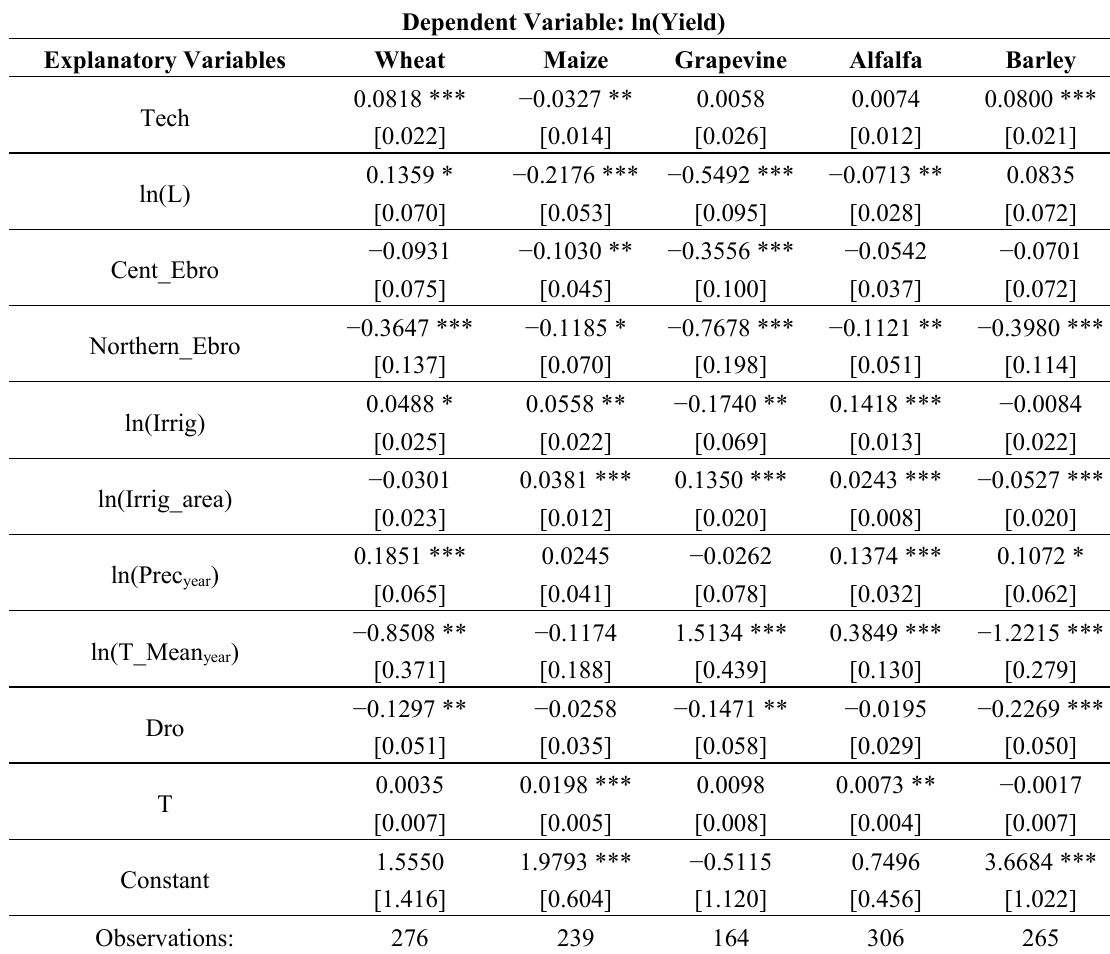
Table 3. Cobb-Douglas crop production